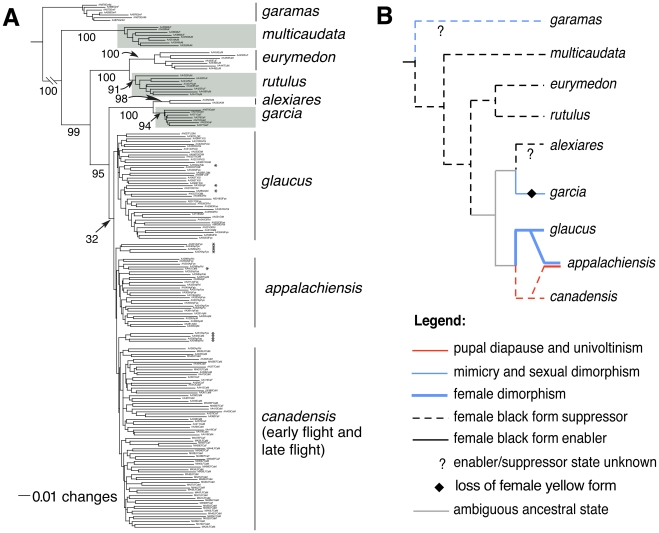
Phylogenetic relationships and character evolution among tiger swallowtails.(A) AFLP-based neighbor-joining tree, with percentage bootstrap support shown for branches. The ten appalachiensis and two canadensis samples that cluster outside their species are marked with asterisks. (B) Character evolution based on the AFLP phylogeny.